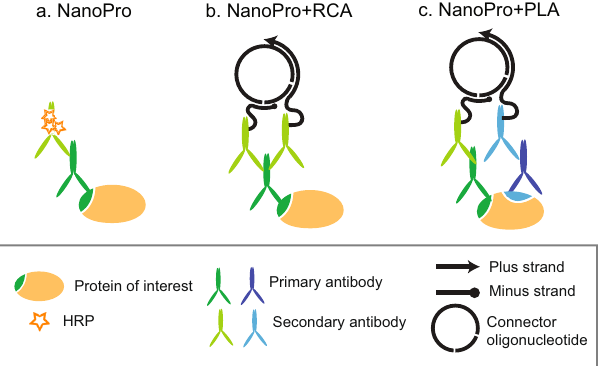
Figure 1. Schematic representation of different assay formats used in the study. ( a ) Capillary IEF using a standard NanoPro 1000 assay. ( b ) RCA-enhanced NanoPro 1000 assay. ( c ) PLA-enhanced NanoPro 1000